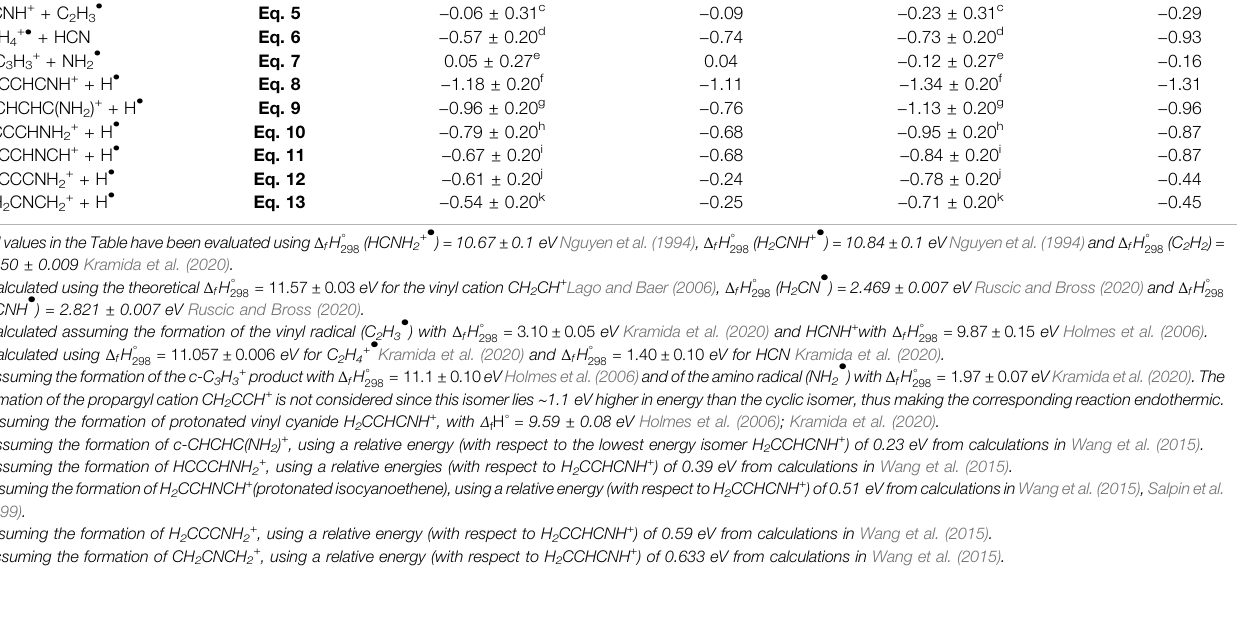
TABLE 1 | Reaction enthalpies for the reaction: HCNH 2+ (cid:129) /H 2 CNH + (cid:129) + C 2 H 2 → products. Products React. No. Δ H ° with HCNH 2 + (cid:129) (eV) a Δ H ° with H 2 CNH + (cid:129) (eV) a Lit. values (298 K) a Calcs. Lit. values (298 K) a Calcs. this work (0 K) this work (0